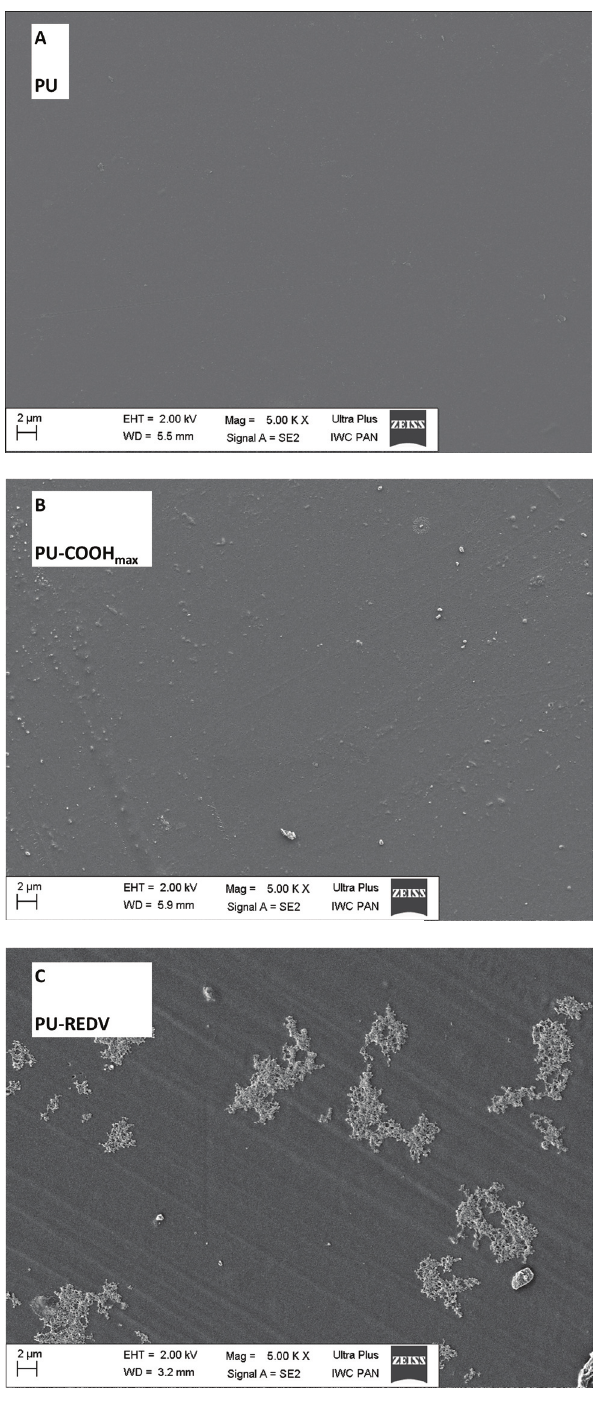
Figure 4: Scanning electron microscope (SEM) images (magnifi cation 5000x) of material surfaces: a) PU, b)PU-COOH